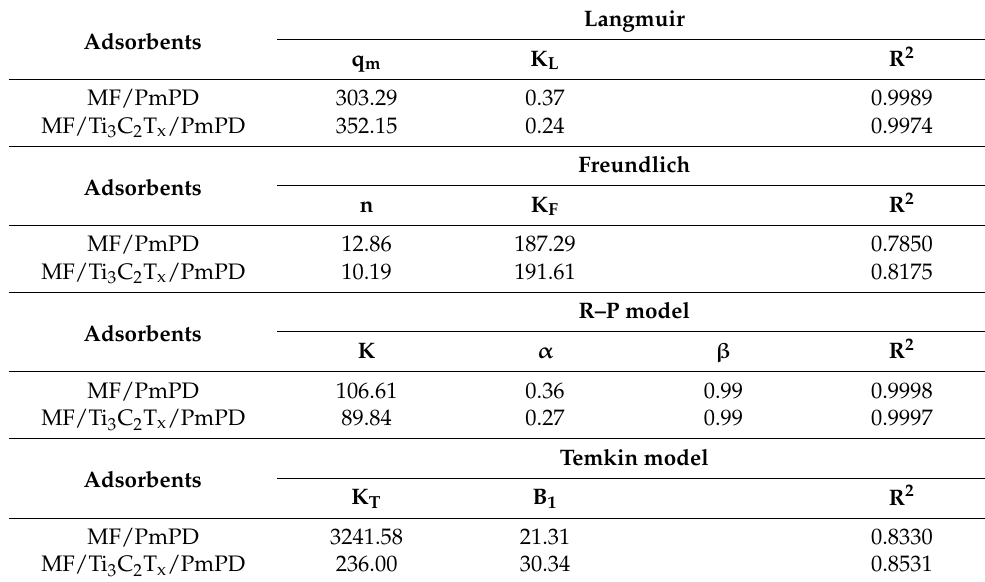
The D–R model was also used to investigate whether the adsorption process of Cr(VI) was physical or chemical adsorption. The fitting line and the correlation coefficient were shown in Figure 8 and Table 2, respectively. The E value (kJ/mol) represents the average free energy, which could be obtained by fitting the D–R model. It can be seen from the table that the E values of MF/PmPD and MF/Ti 3 C 2 T x /PmPD were 21.32 and 18.7 kJ/mol, respectively, which were greater than 16 kJ/mol, suggesting that the adsorption process was dominated by chemical adsorption.